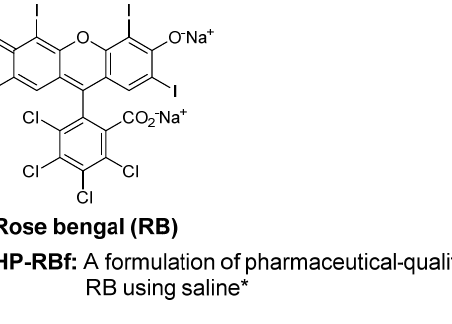
Figure 1. Rose bengal (RB) with >99% purity. * A 10% concentration of pure RB disodium salts in saline solution was applied in this article. Table 1. MIC of a series of Gram-positive and -negative bacteria via the broth dilution method a .